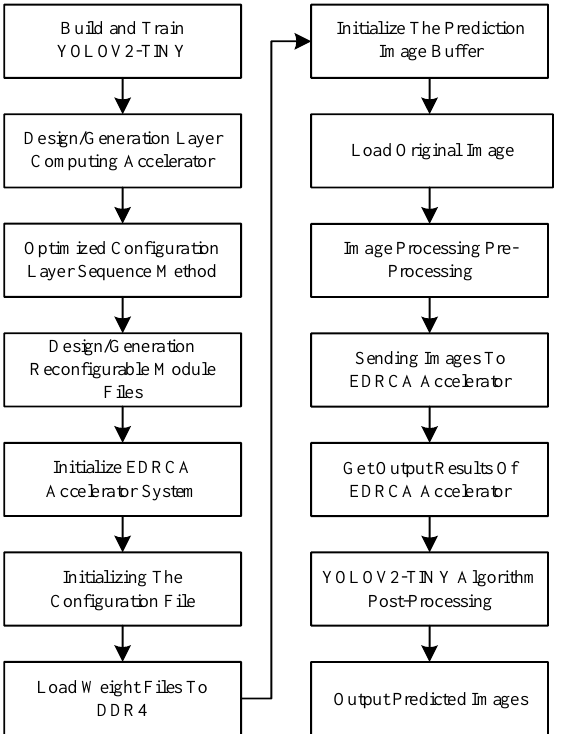
Figure 6. Implementation flow for hardware deployment of YOLOV2-Tiny.